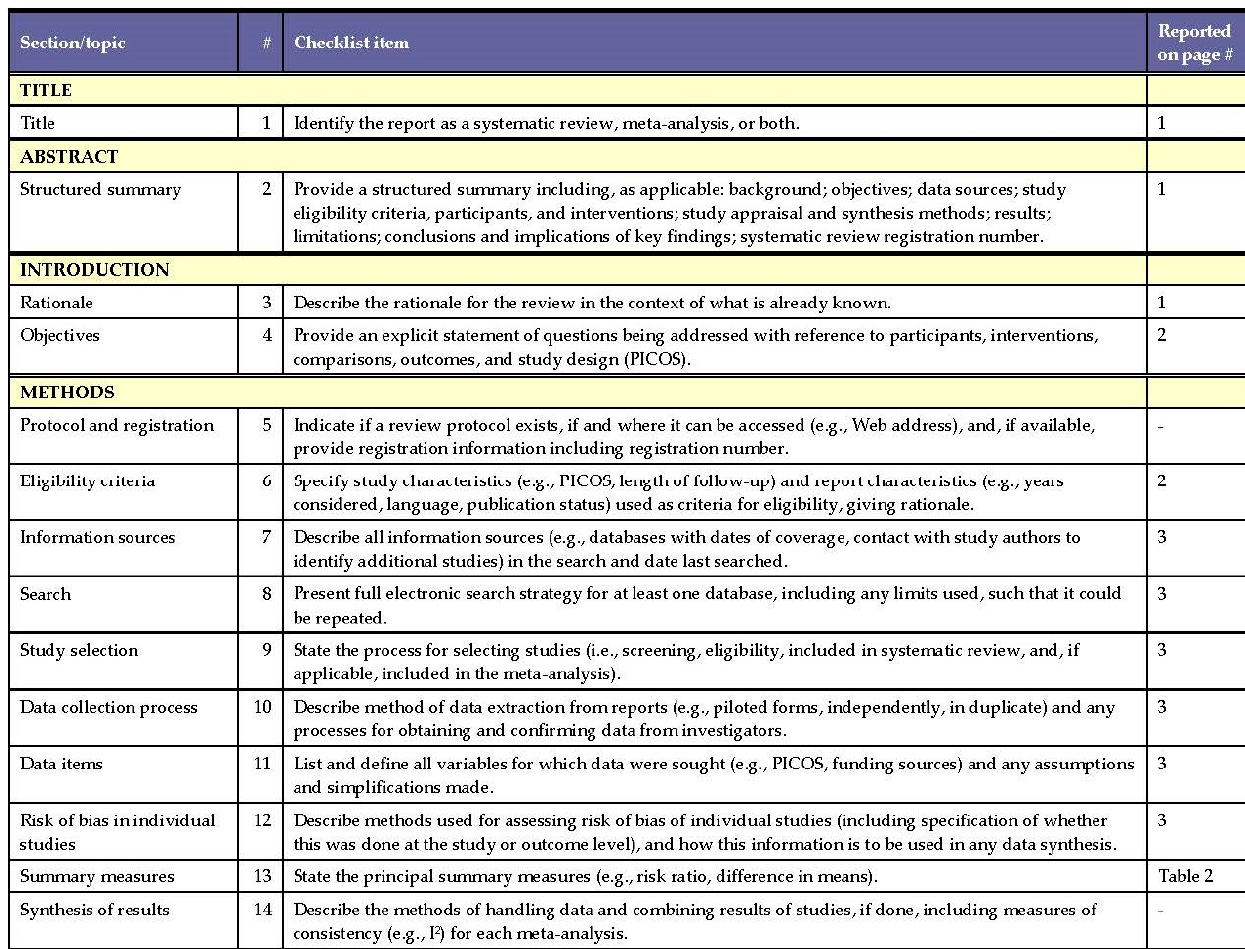
Figure A1. PRISMA Checklist [35].